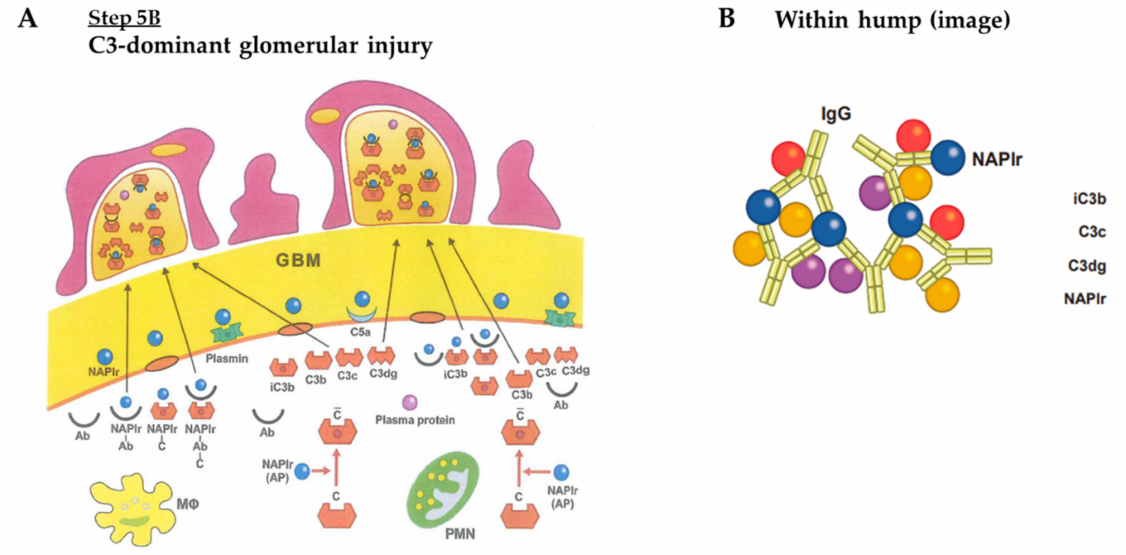
Figure 17. ( A ): C3-dominant glomerular injury. ( B ): NAPlr is fully saturated with IgG and com- plement components, and IgG is also fully saturated with complement components. Ab: antibody, NAPlr-Ab: NAPlr-antibody, NAPlr-C: NAPlr-complement complex, NAPlr-Ab-C: NAPlr-antibody- complement complexes, C bar: activated complement, iC3b: inactivated C3b, A-P: alternative pathway, M Φ : macrophage, PMN; polymorphonuclear neutrophil, NAPlr: nephritis-associated plasmin